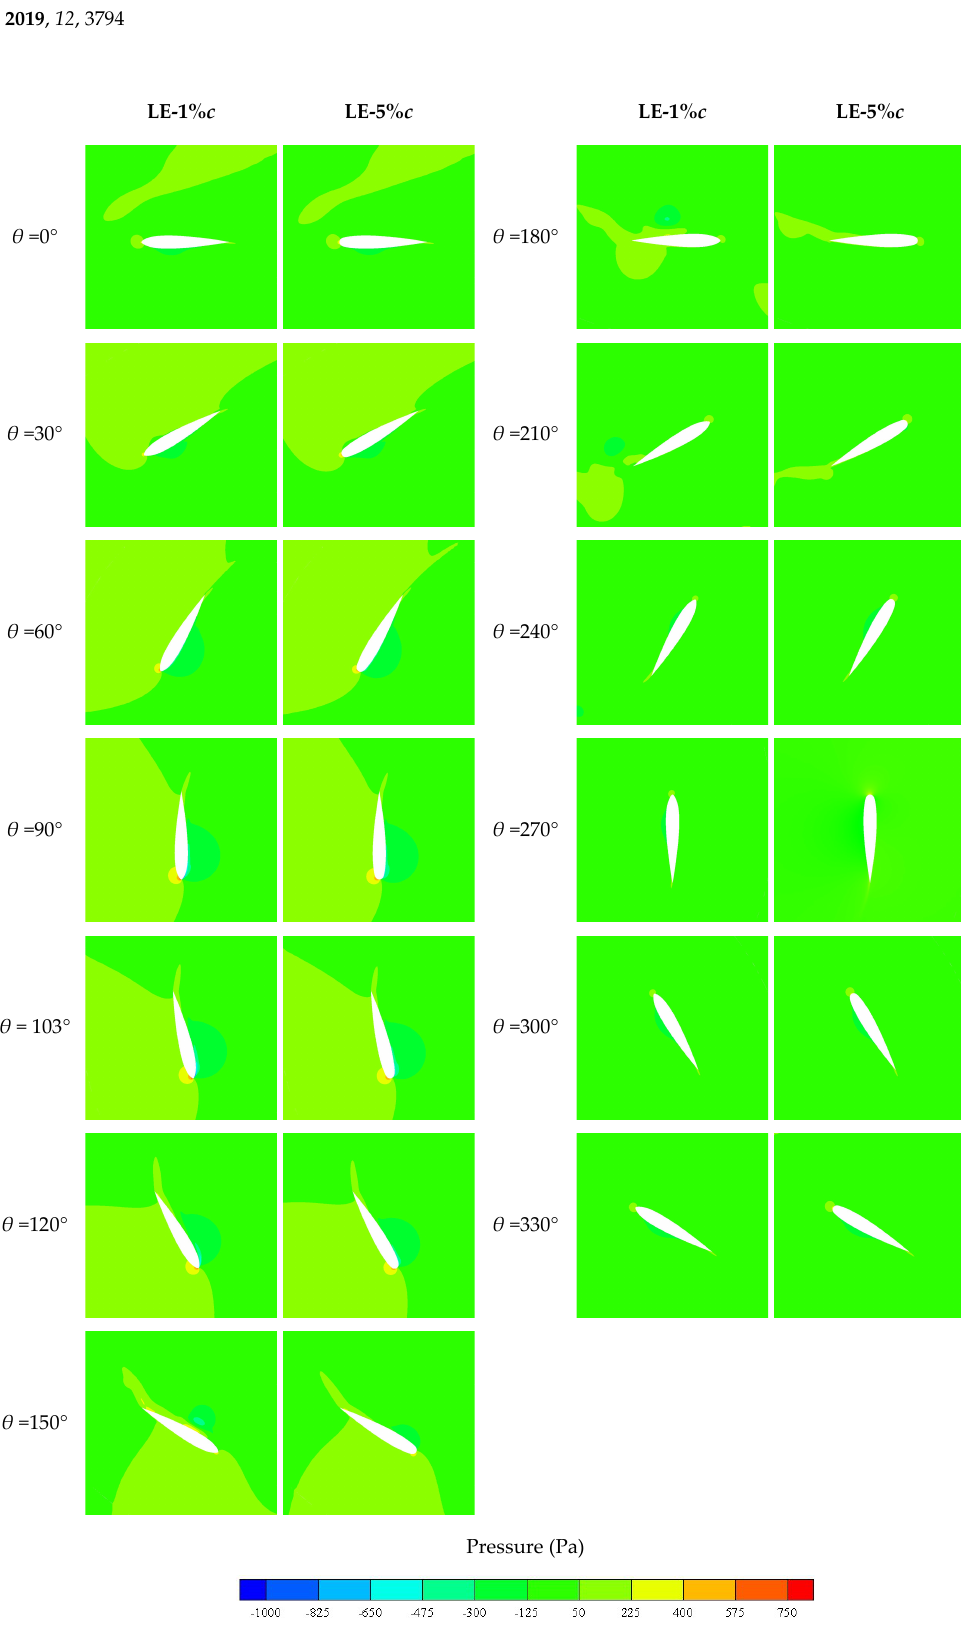
Figure 13. Contours of pressure distribution of blade 1 with di ff erent airfoil leading edge radius during one rotational period at TSR =